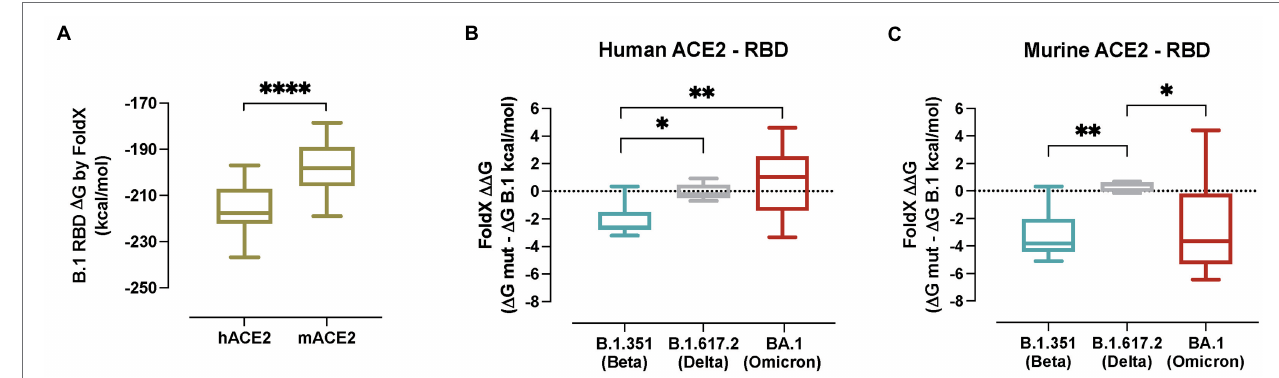
FIGURE 6 | In silico modelling of the affinity of SARS-CoV-2 variants for human and murine ACE2. (A) Gibbs free energy of the FoldX models of hACE2 and mACE2 in complex with the S RBD from SARS-CoV-2 B.1 RBD. Complexes with lower energies are predicted as having higher binding affinities. Statistically significant differences were found using a Mann–Whitney test ( **** p < 0.0001). (B) Predicted binding affinity changes induced by VOCs B.1.351/Beta (blue), B.1.617.2/Delta (grey) and BA.1/Omicron (red) of the S RBD in complex with human ACE2. (C) Predicted binding affinity changes induced by VOCs B.1.351/Beta (blue), B.1.617.2/Delta (grey) and BA.1/Omicron (red) of the S RBD in complex with murine ACE2. Statistically significant differences were found using a Kruskal- Wallis with Connover’s all-pairs test multiple comparisons ( * p < 0.05; ** p < 0.01; **** p <